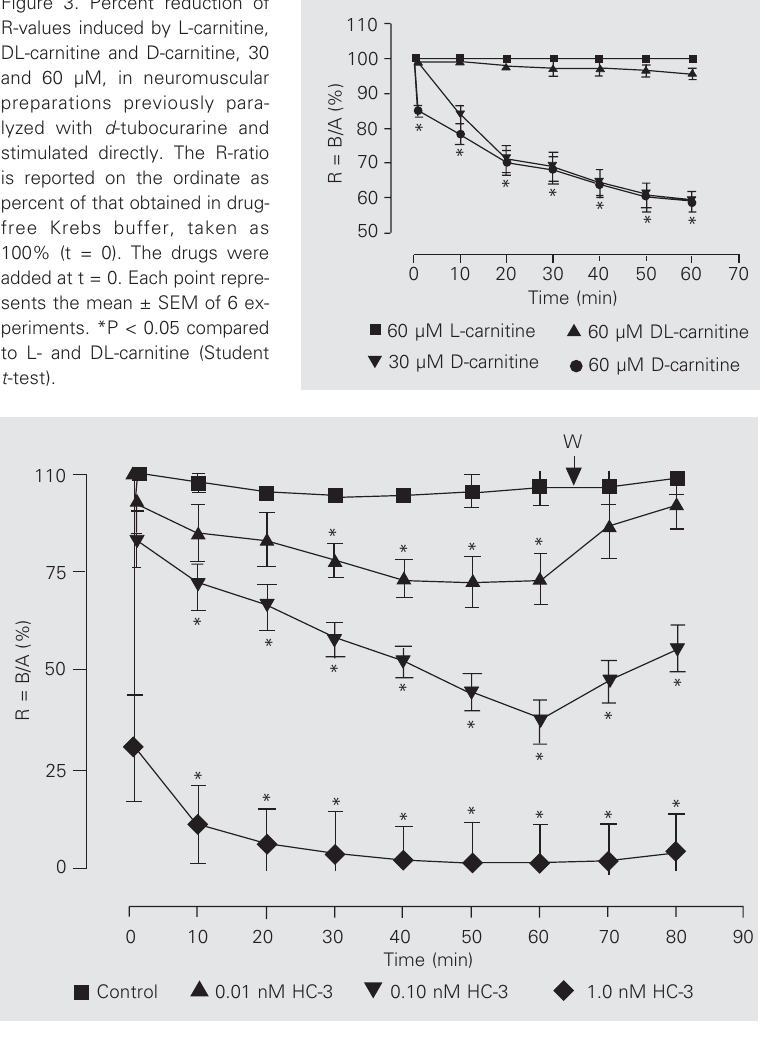
Figure 4. Percent reduction in R-values induced by hemicholinium-3 (HC-3) in indirectly stimulated neuromuscular preparations of rats. The R-ratio is reported on the ordinate as percent of that obtained in drug-free Krebs buffer, taken as 100% (t = 0). The drugs were added at t = 0. W indicates replacement of drug-free Krebs buffer (four times). Each point represents the mean ± SEM of 6 experiments. *P < 0.05 compared to control (Student t -